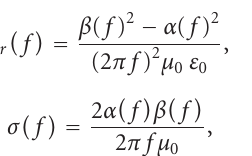
Figure 6: Measurement system integrated in the user